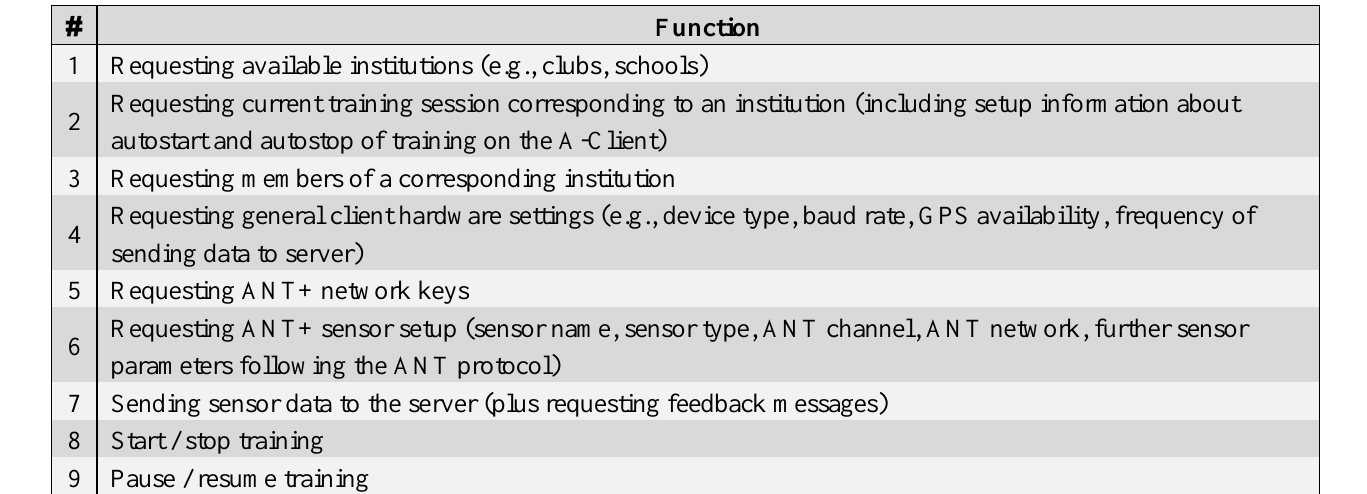
Table 1. Message formats used in the